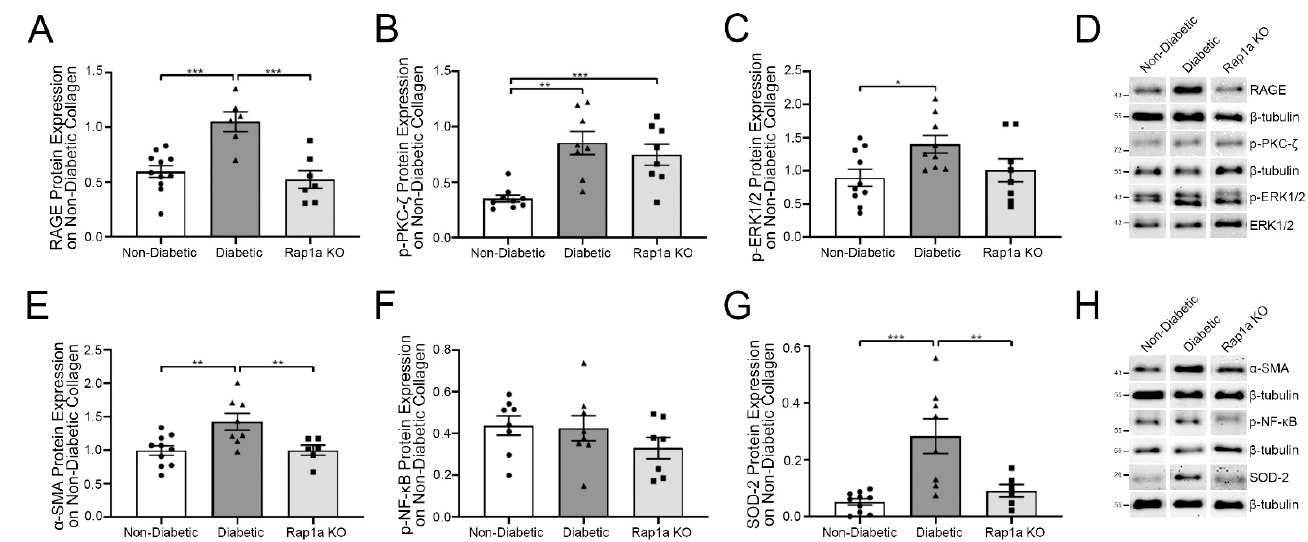
Figure 1. Diabetic cardiac fibroblasts exhibited higher levels of RAGE-associated signaling proteins compared to non-diabetic and Rap1a fibroblasts. Non-diabetic, diabetic, and Rap1a KO cardiac fibroblasts were isolated and P1 fibroblasts were cultured on collagen isolated from non-diabetic mouse tails. Total protein was collected from fibroblasts and assessed for changes in protein expression between non-diabetic, diabetic, and Rap1a KO fibroblasts. RAGE signaling proteins were determined by analyzing protein expression of ( A ) ( G ) RAGE (46 kDa), ( B ) p-PKC- ζ (72 kDa), and ( C ) p-ERK1/2 (44 and 42 kDa, respectively). ( D ) Representative Western blot images for RAGE, p-PKC- ζ , and p-ERK1/2, are presented. Downstream targets of AGE/RAGE signaling were assessed by examining protein expression for ( E ) α -SMA (42 kDa), ( F ) p-NF- κ B (65 kDa), and ( G ) SOD-2 (25 kDa). ( H ) Representative Western blot images for α -SMA, p-NF- κ B, and SOD-2., and all Western blot images are not displayed as continuous blots due to logistical constraints brought on by the number of treatment groups and genotypes. The original Western blot images are available at DOI:10.6084/m9.figshare.13369535. Protein expression for α -SMA, p-NF- κ B, SOD-2, p-PKC- ζ , and RAGE was normalized to β -tubulin (55 kDa), and p-ERK1/2 protein expression was normalized to total ERK1/2 protein expression. Mean + SEM are depicted on graph ( n = 6–11) and significance was determined by one-way ANOVA followed by a Fisher’s Protected Least Significant Difference post hoc (* p < 0.05, ** p < 0.01, and *** p < 0.001).